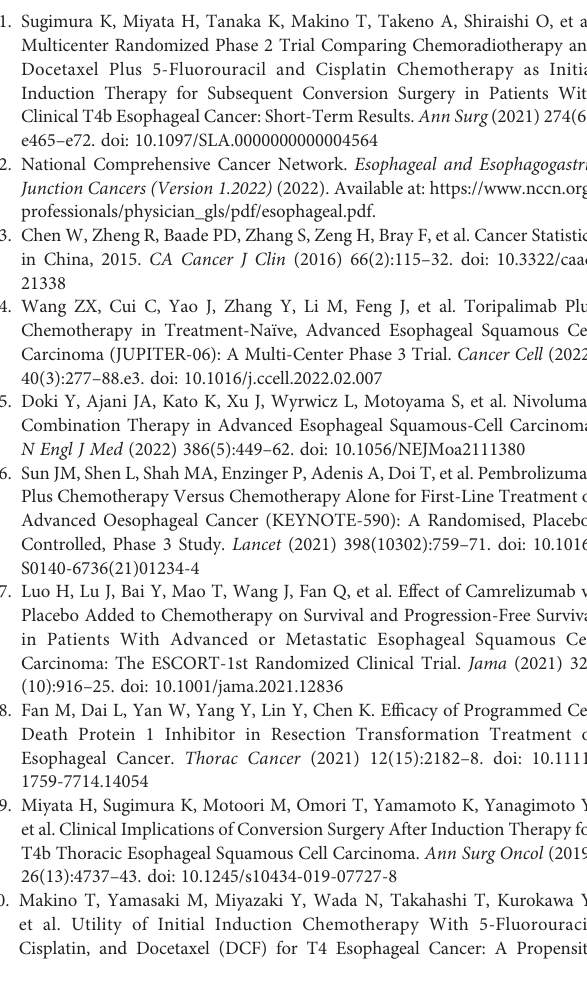
Supplementary Figure 1 | Association between treatment-related adverse events and clinicopathological information. The clinical heatmap depicts the included individuals ’ clinicopathological features and their reported adverse events. Different color blocks were used to classify each clinicopathological features. Darkness of red color represents severity of the treatment-related adverse events. Supplementary Figure 2 | Swimmer plot (A) and waterfall plot (B) . (A) The swimmer plot depicts each patient as one line. C1 represents the fi rst cycle from initiation of the fi rst immunochemotherapy to initiation of the second immunochemotherapy and so on. Various colors and shapes are used to represent the radiological outcomes and treatment-related adverse events. (B) Maximum radiological response from baseline. Color blocks represent different radiological outcome per RECIST 1.1. Supplementary Figure 3 | Event-free survival according to willingness to undergo conversion surgery among surgical